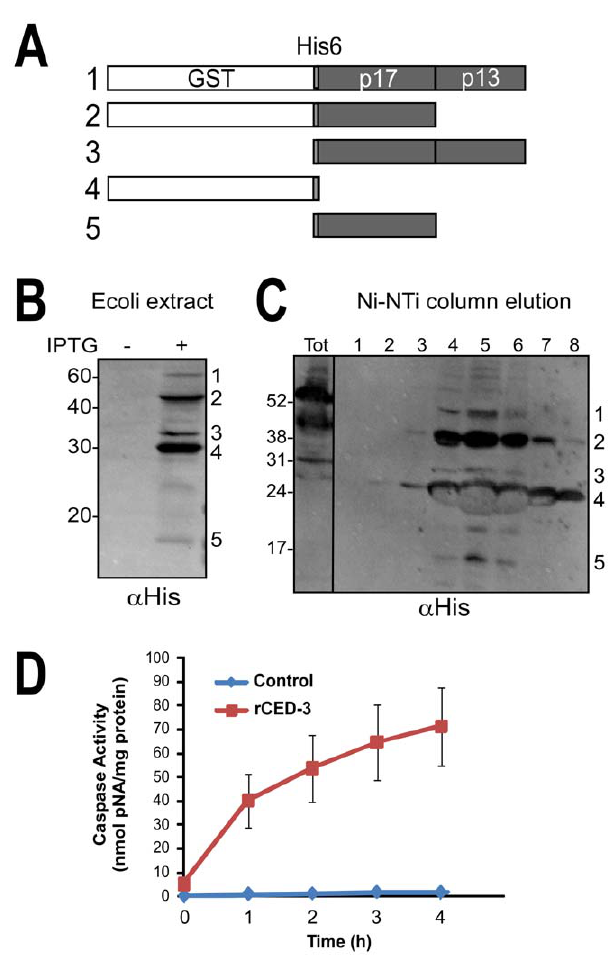
Figure 2. Generating catalytically active C.elegans recombinant CED-3. (A) Schematic depicting rCED-3 processed intermediates produced in E. coli. The full length (58 kDa) CED-3 consists of the catalytic amino acids 221–503 fused to GST and six His tags. Autocatalysis of rCED-3 into individual subunits (p17 and p13) that are required to create the mature heterotetramer are numbered 1–5. (B) rCED-3 expression was induced in E. coli using 100 m M IPTG and lysates analyzed by immunoblotting with an anti-His6 monoclonal antibody (Genscript). The mature p13 subunit contains no His6 tag and is therefore not detected. (C) The tagged proteins were subsequently purified by Ni-NTA affinity chromatography and elutions subjected to western blotting with His6 antibodies. (D) Caspase activity for rCED-3 was determined using chromogenic substrate Ac-DEVD-pNA (Promega) and measured at a wavelength of 405 nm. Partially purified enzyme (10 m l; 133–196 m g total protein) was added to the substrate (0.2 mM) and the rate of proteolysis monitored over a 4 h period. Activity (U) is expressed as nmoles pNA released per milligram protein per hour. Caspase activity (35 U/h) was compared to control reactions containing equivalent amounts of a bovine serum albumin (0.78 U/h), showing a 44-fold increase in rate. Data is representative of three independent preparations of rCED-3. Error bars are S.E.M.